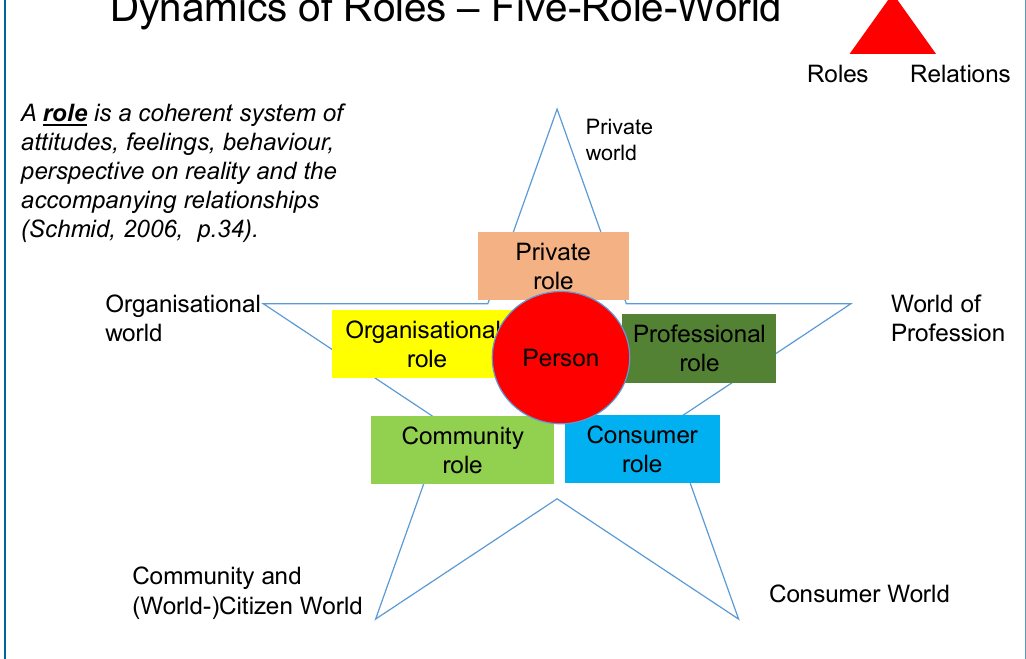
Figure 2: Schmid’s (1994) and Mohr’s (2012) Model of Role Worlds